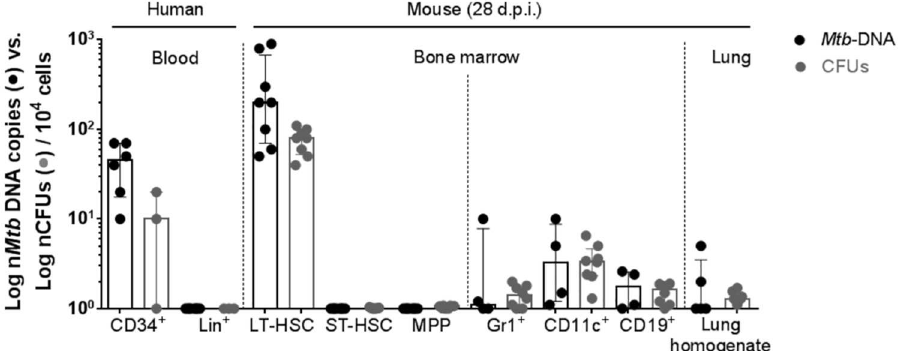
Fig 4. Numbers of Mtb DNA copies ( MPB64 qPCR) and CFUs in 10 4 cells of different cell populations. Data are shown as median+ interquartile (n =